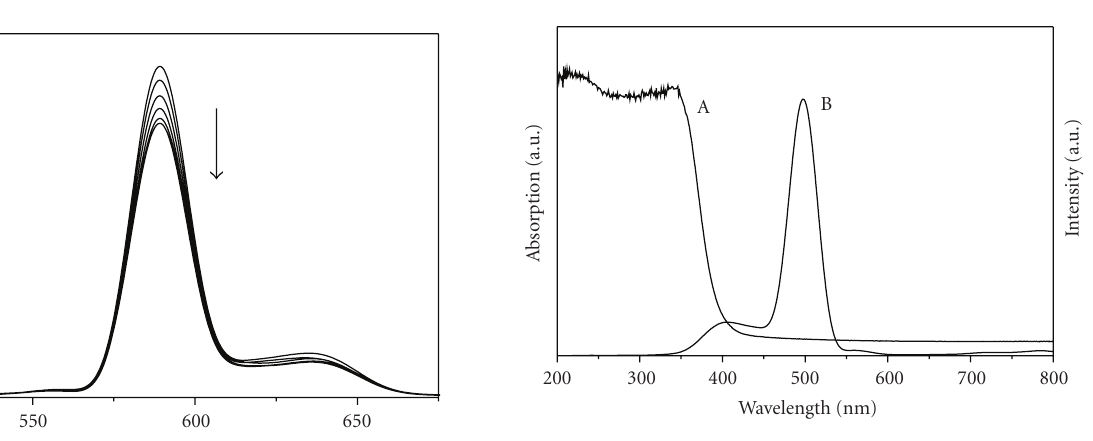
Figure 5: Absorption spectrum of TiO 2 (A) and emission spectrum of ZnPP (B).